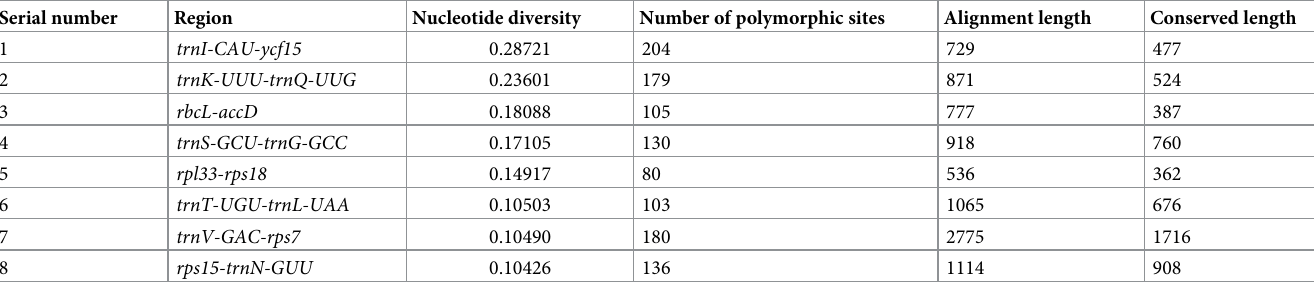
Table 6. Polymorphic loci identified based on comparative analysis of chloroplast genomes of T . mongolica , Z . xanthoxylon , and Z . fabago .